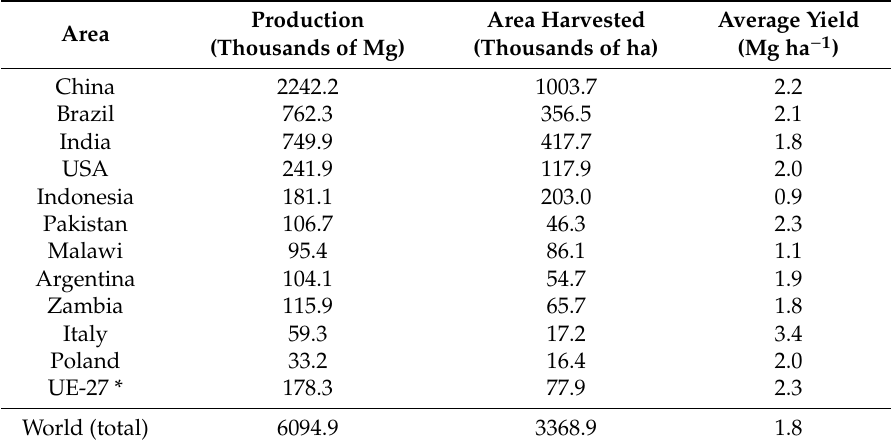
Table 1. The world’s largest producers of tobacco